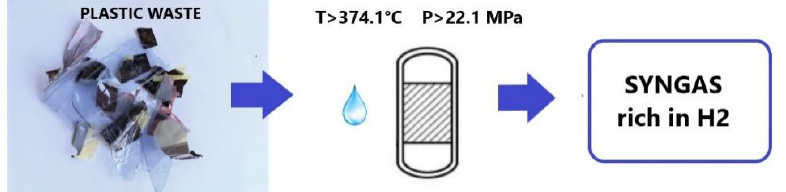
Figure 4. Graphical scheme of the supercritical water gasification (SCWG) of waste plastics.